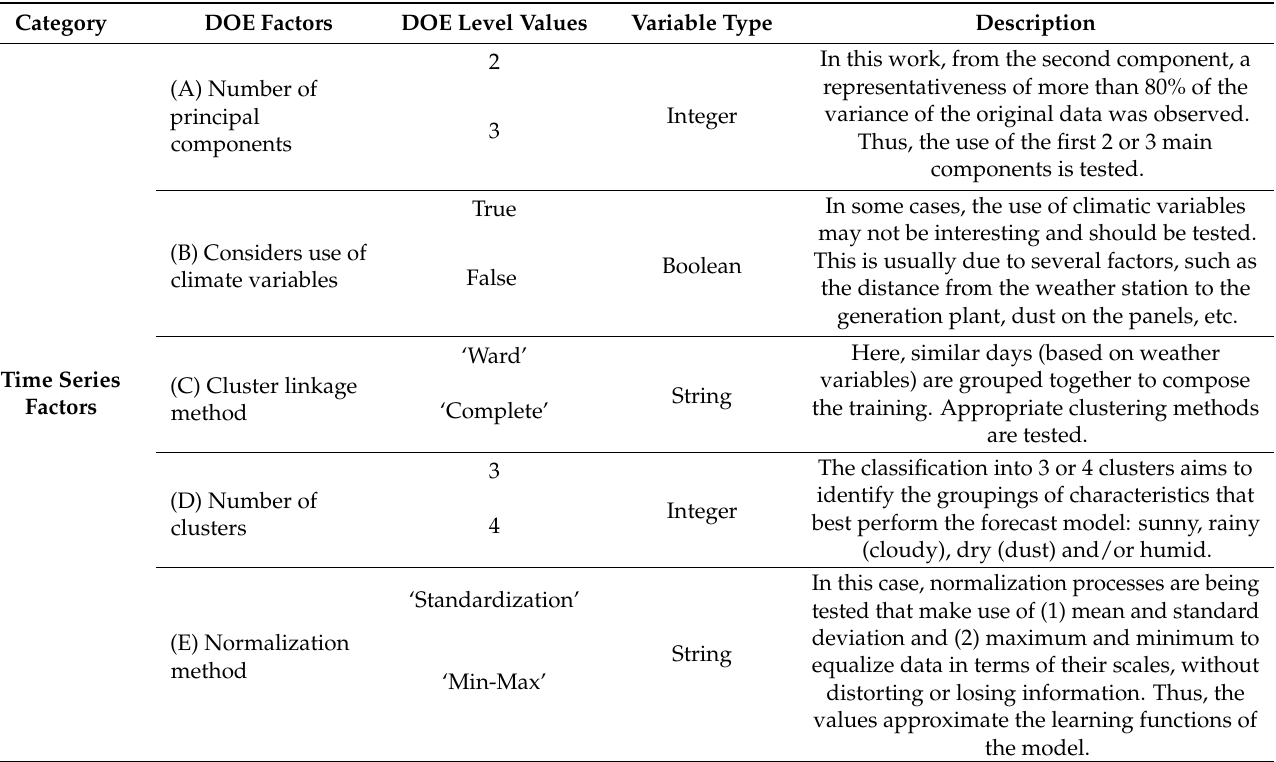
Table 3. DOE Factors and Levels.